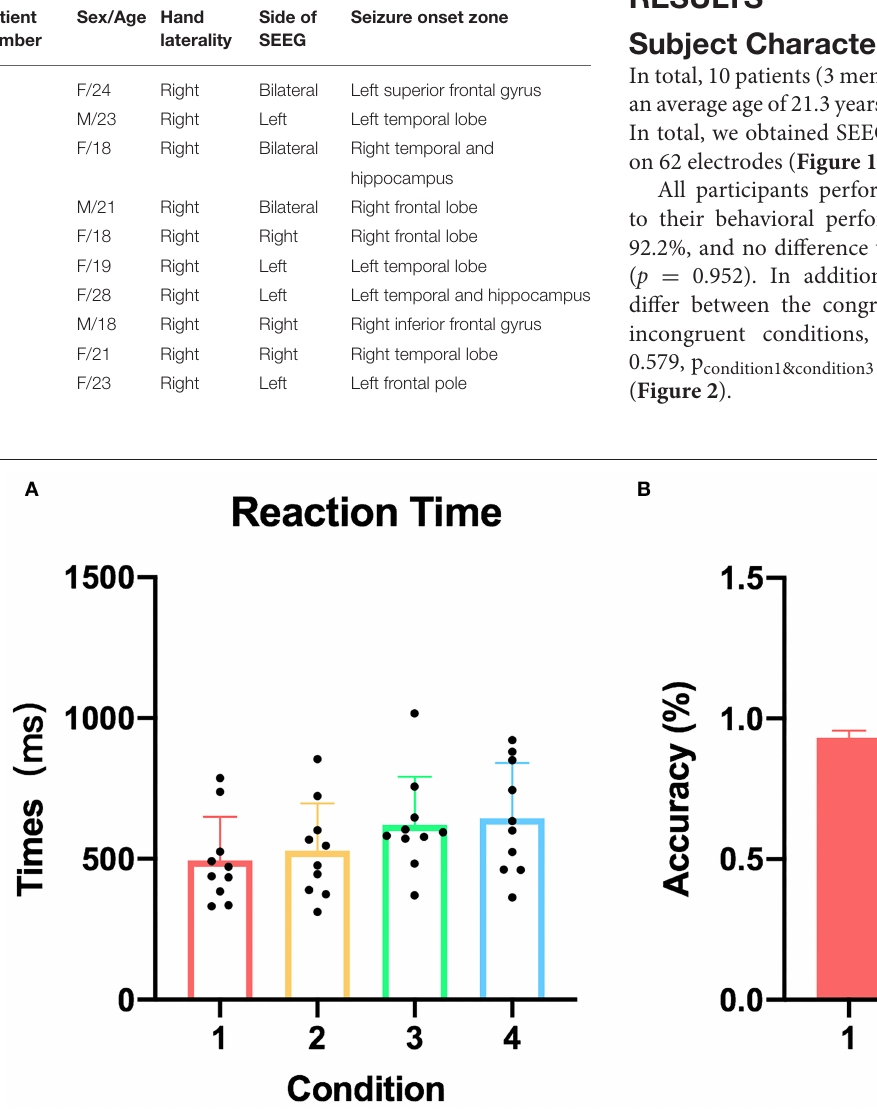
FIGURE 2 | Reaction time and correct response rate of each condition. (A) The reaction time in all participants (condition 1: congruent, condition 2: irrelevant incongruent, condition 3: relevant incongruent, and condition 4: conjunction incongruent). (B) The correct response rate in all participants.